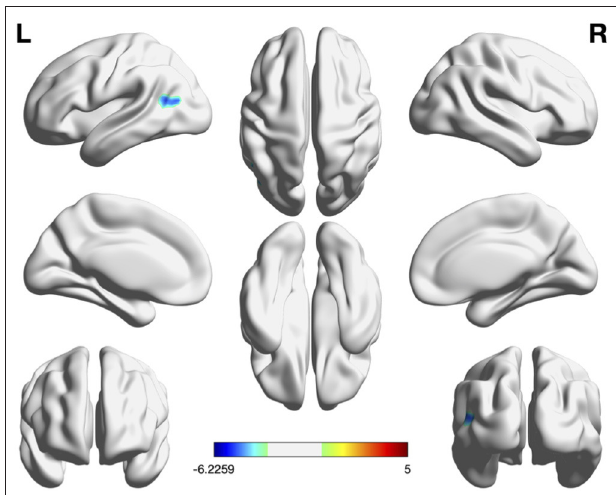
FIGURE 1 | Significant regions in group comparison of FC, fALFF, and ReHo. In group comparison, cool color indicate regions showing lower values and warm color indicate regions showing higher values in the A β + group than in A β – . The color bar indicates the T -score. Threshold: p < 0.05, false discovery rate-corrected at cluster level. Region-of-interest based FC was the only measure showing group difference in voxelwise analysis. A β + , cognitively normal older adults with beta amyloid retention; A β − , cognitively normal older adults without beta amyloid retention; fALFF, fractional amplitude of low-frequency fluctuations; FC, Functional connectivity; ReHo, regional homogeneity.